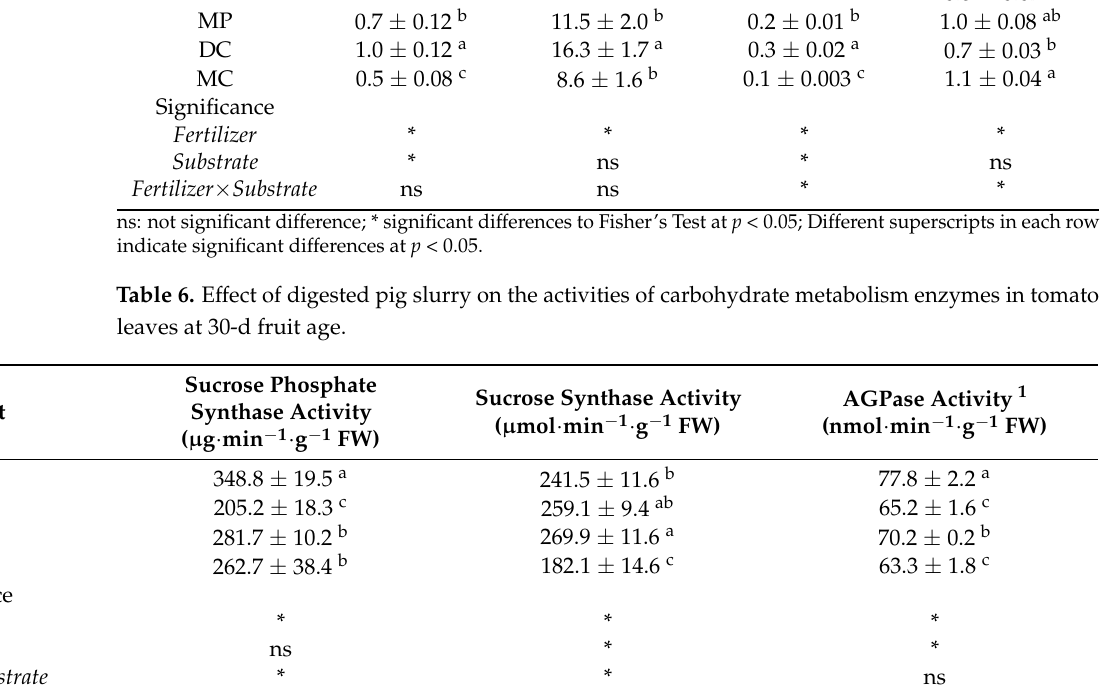
scripts in each row indicate significant differences at p < 0.05.